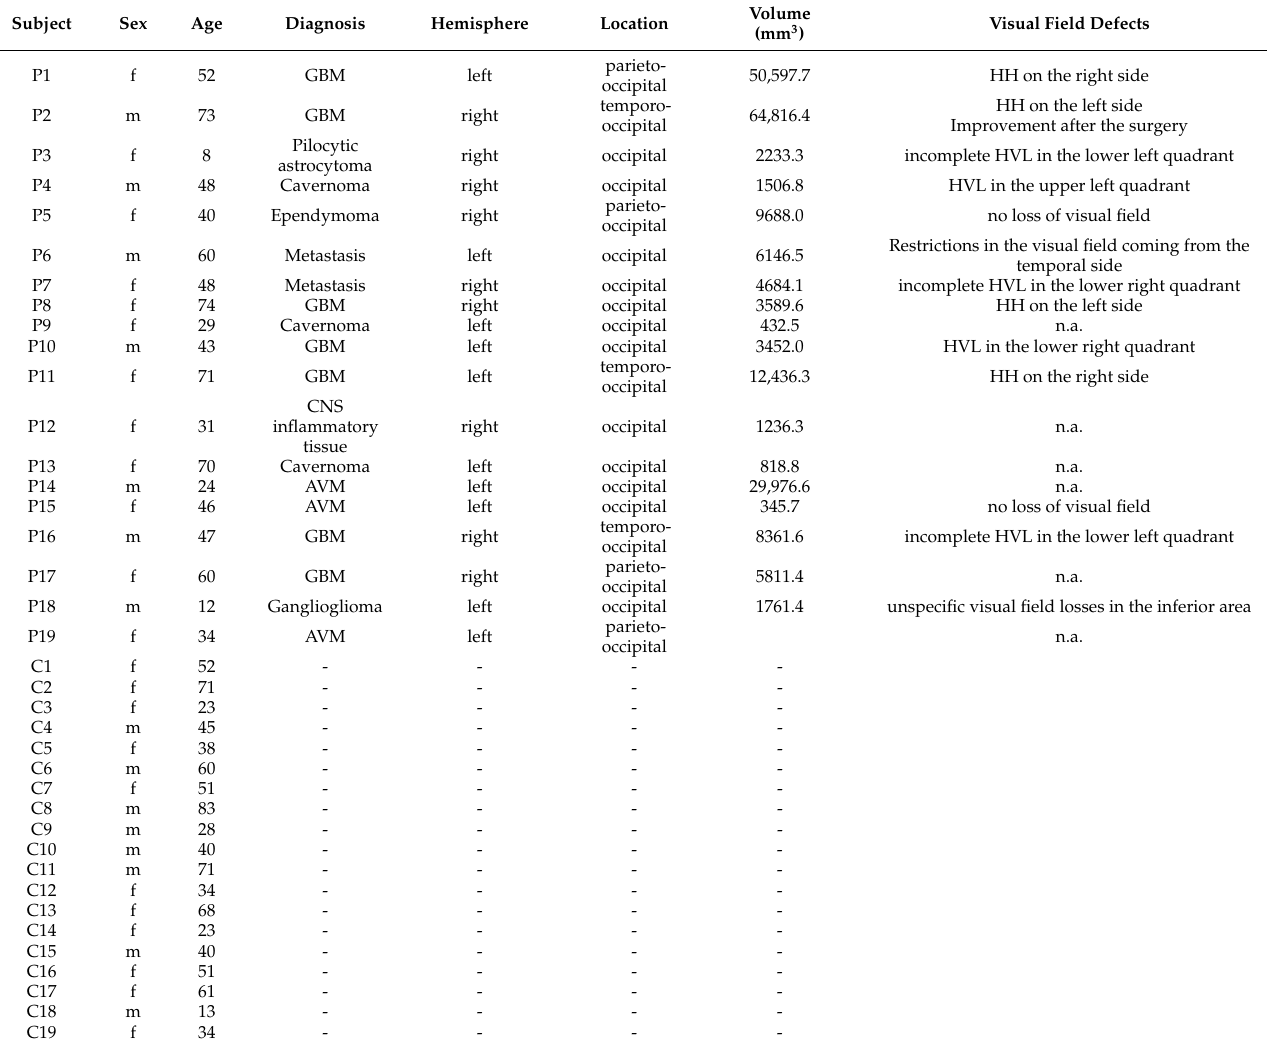
control subjects and a blue dot for the patients. To identify the activation pattern of three different eccentricities in the visual cortex along the calcarine sulcus, cortical responses to the presentation of concentric circles with flickering checkerboard patterns were measured. This was done as described in other studies [18,23,46]. Table 1. Sociodemographic data and diagnosis of the examined patients (P1–P19) and their corresponding